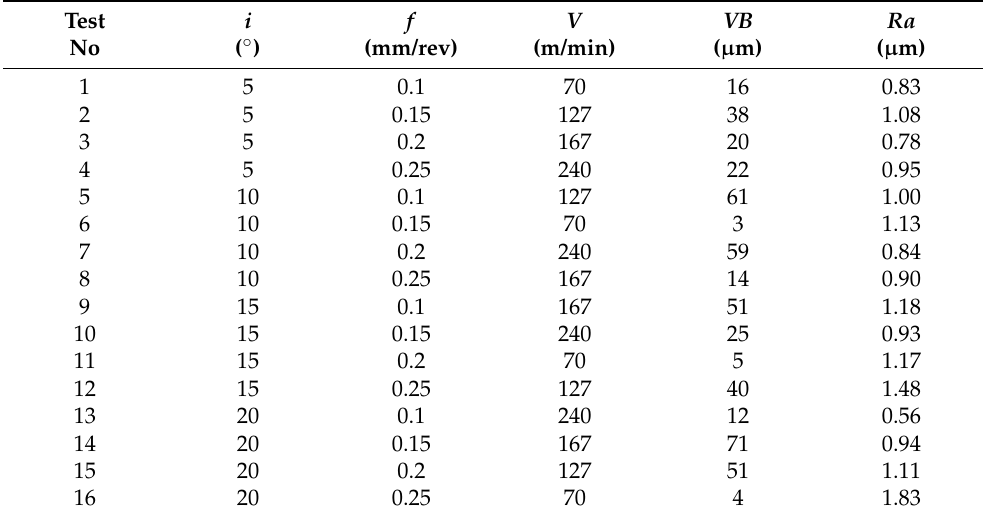
Table 4. Average surface roughness ( Ra ) and tool wear ( VB ) results, where (i ) is the inclination angle, ( f ) is the feed rate, and ( V ) is the cutting